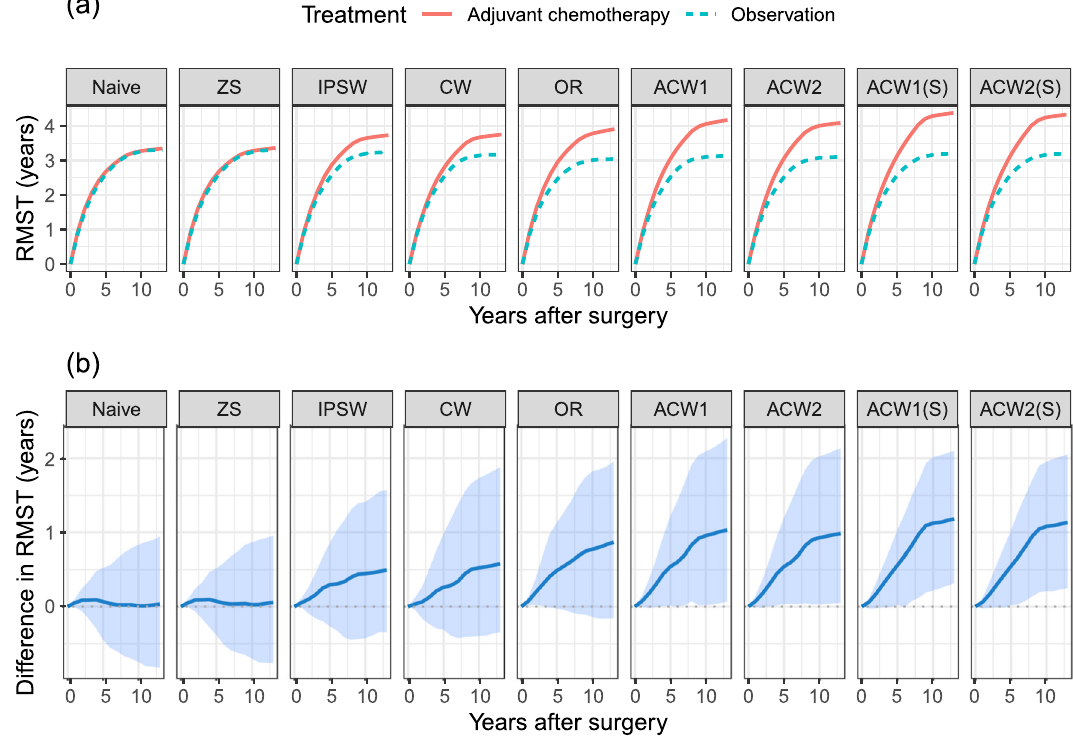
Figure 3: Estimated RMST plots of adjuvant chemotherapy and observation and their di ff erence as a function of restricted